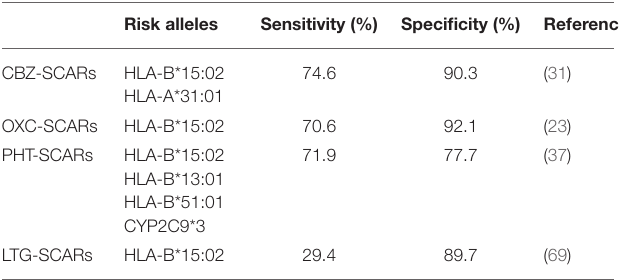
TABLE 2 | Pharmacogenomic panel linked to AED-related SCARs in